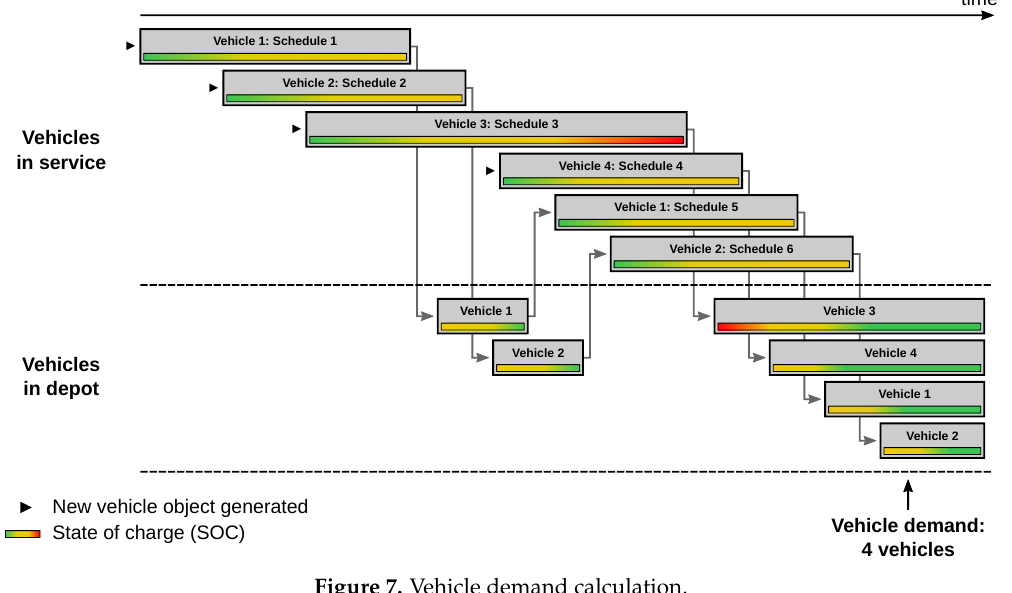
Figure 7. Vehicle demand